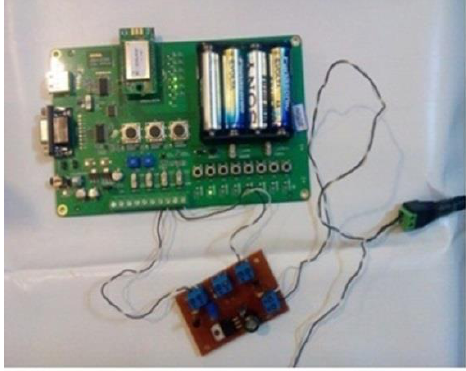
Figure 9. Overall configuration of wireless sensor network used in SHM system. Figure 10. Node 2 (end